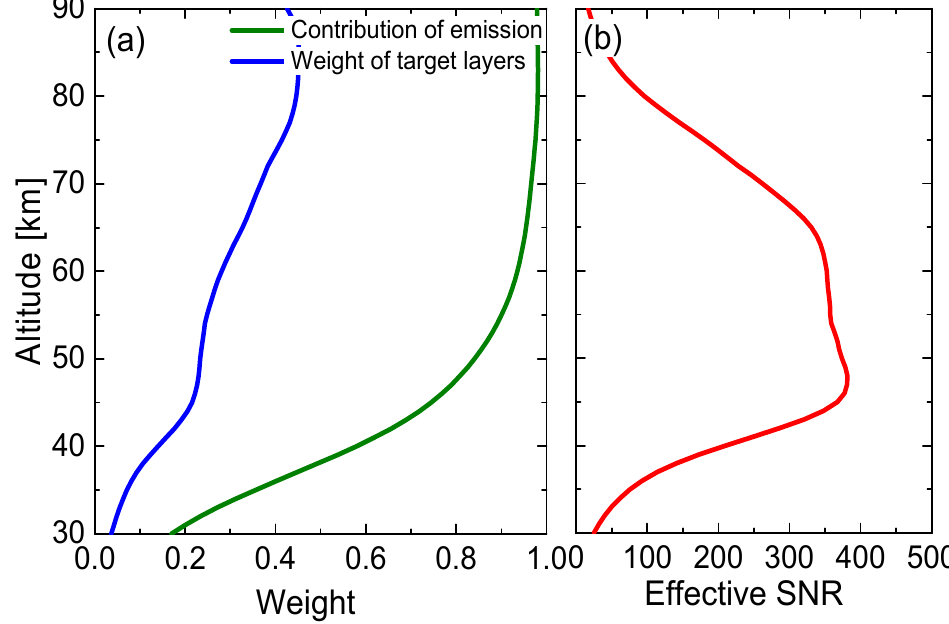
Figure 11. The limb-viewing weight and the contribution rate of the pure emission atmospheric signal ( a ) and the effective SNR; ( b ) varying with tangent altitude.